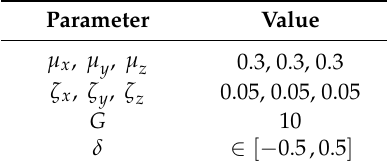
Table 2. Reference values for the parameters in environmental